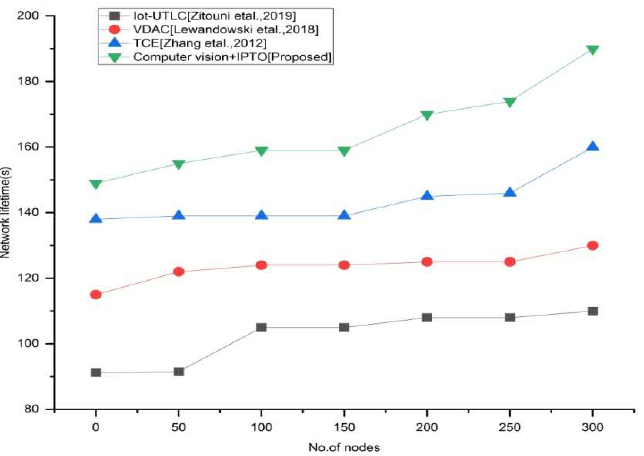
Figure 8. Network lifetime vs. number of nodes for the existing and proposed method.